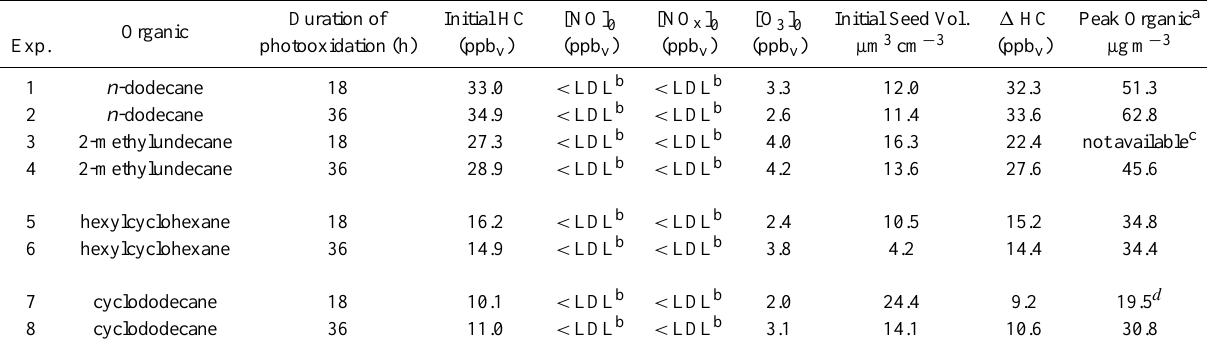
Table 2. Experimental conditions.